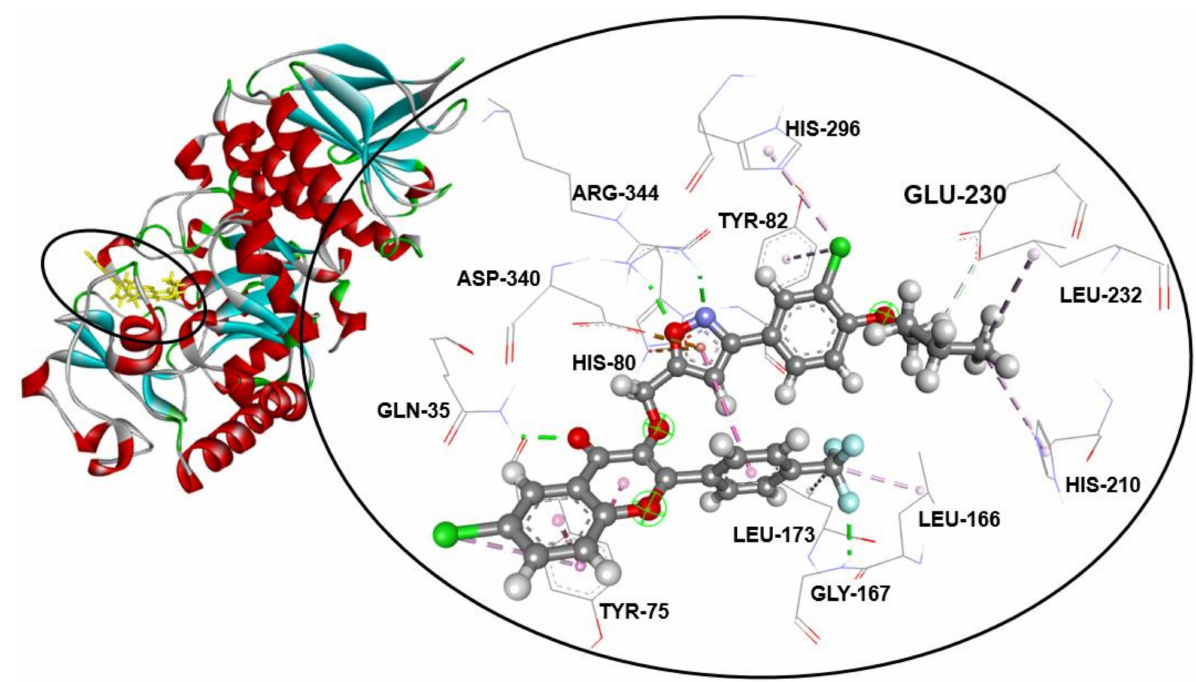
Figure 3. Compound 3j fits into the hydrophobic binding pocket of ABC in PDB: